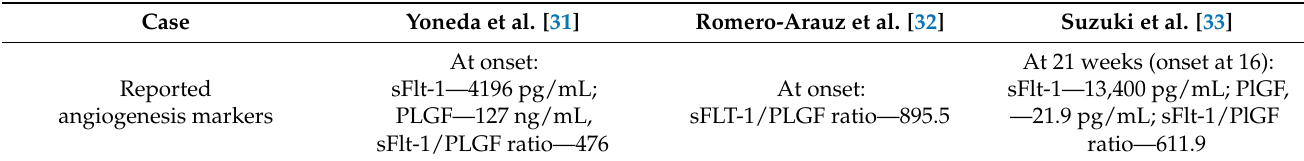
Figure 3. Pregnancy outcome—number of cases (%); maternal comorbidities—number of cases. * Selective termination and live birth of other twin/triplets. APS—antiphospholipid syndrome, PPH—pre-pregnancy hypertension. Table 2. Reported angiogenesis markers. Soluble FMS-like tyrosine kinase-1 (sFlt-1)/Placental growth factor (PLGF). Case